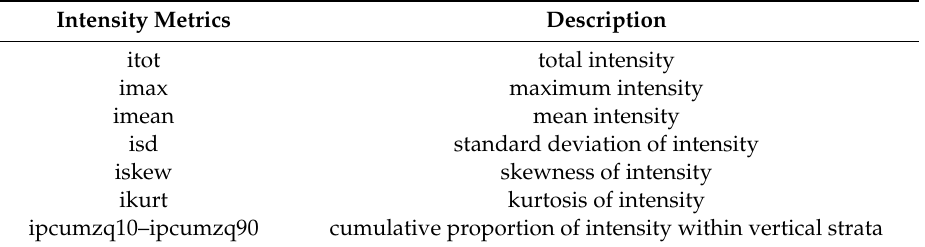
Table 4. List of intensity metrics calculated for M-ALS point